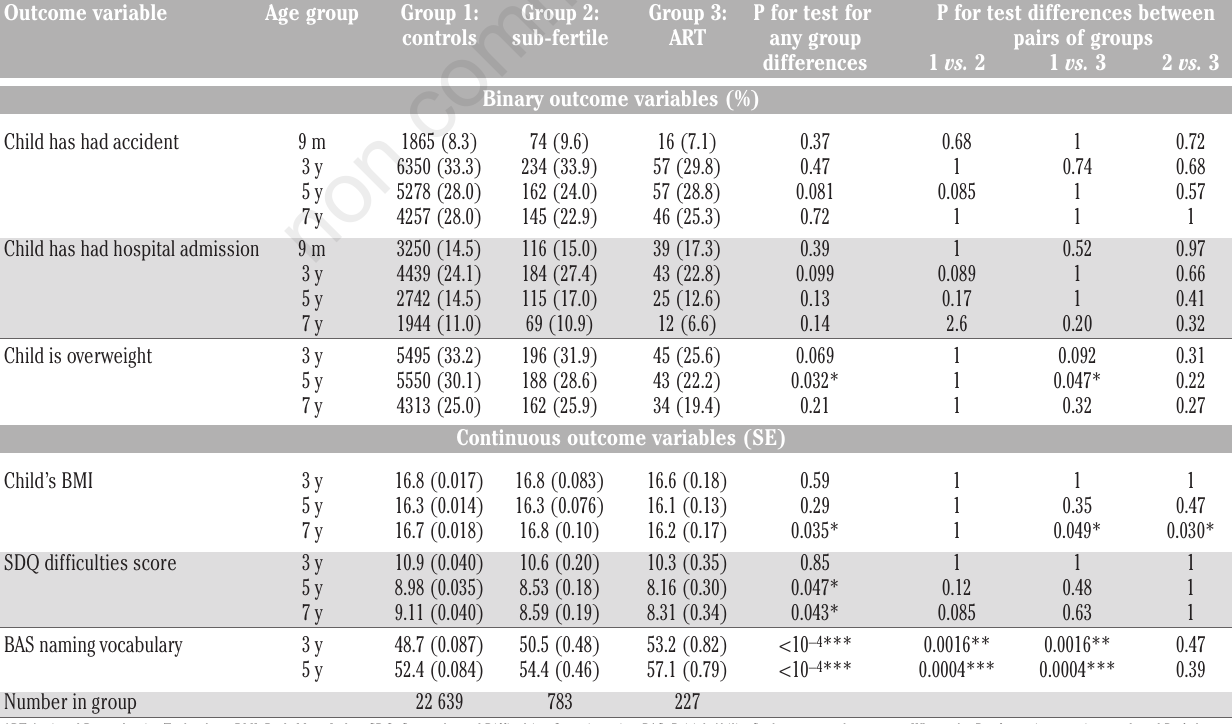
Table 1. Summary of unadjusted comparisons of outcome variables by group. For the binary variables, numbers of cases are given, with the percentage of the group this represents in brackets. For the continuous variables, group means are given with their standard error in brackets. The P for an ANOVA test for group differences is shown, along with the P for tests for differences between each pair of groups, using a Bonferroni correction to maintain the Type I error rate of 5%. Higher SDQ Difficulties Score values indicate greater child difficulties. Higher BAS Naming Vocabulary Scores indicate larger child